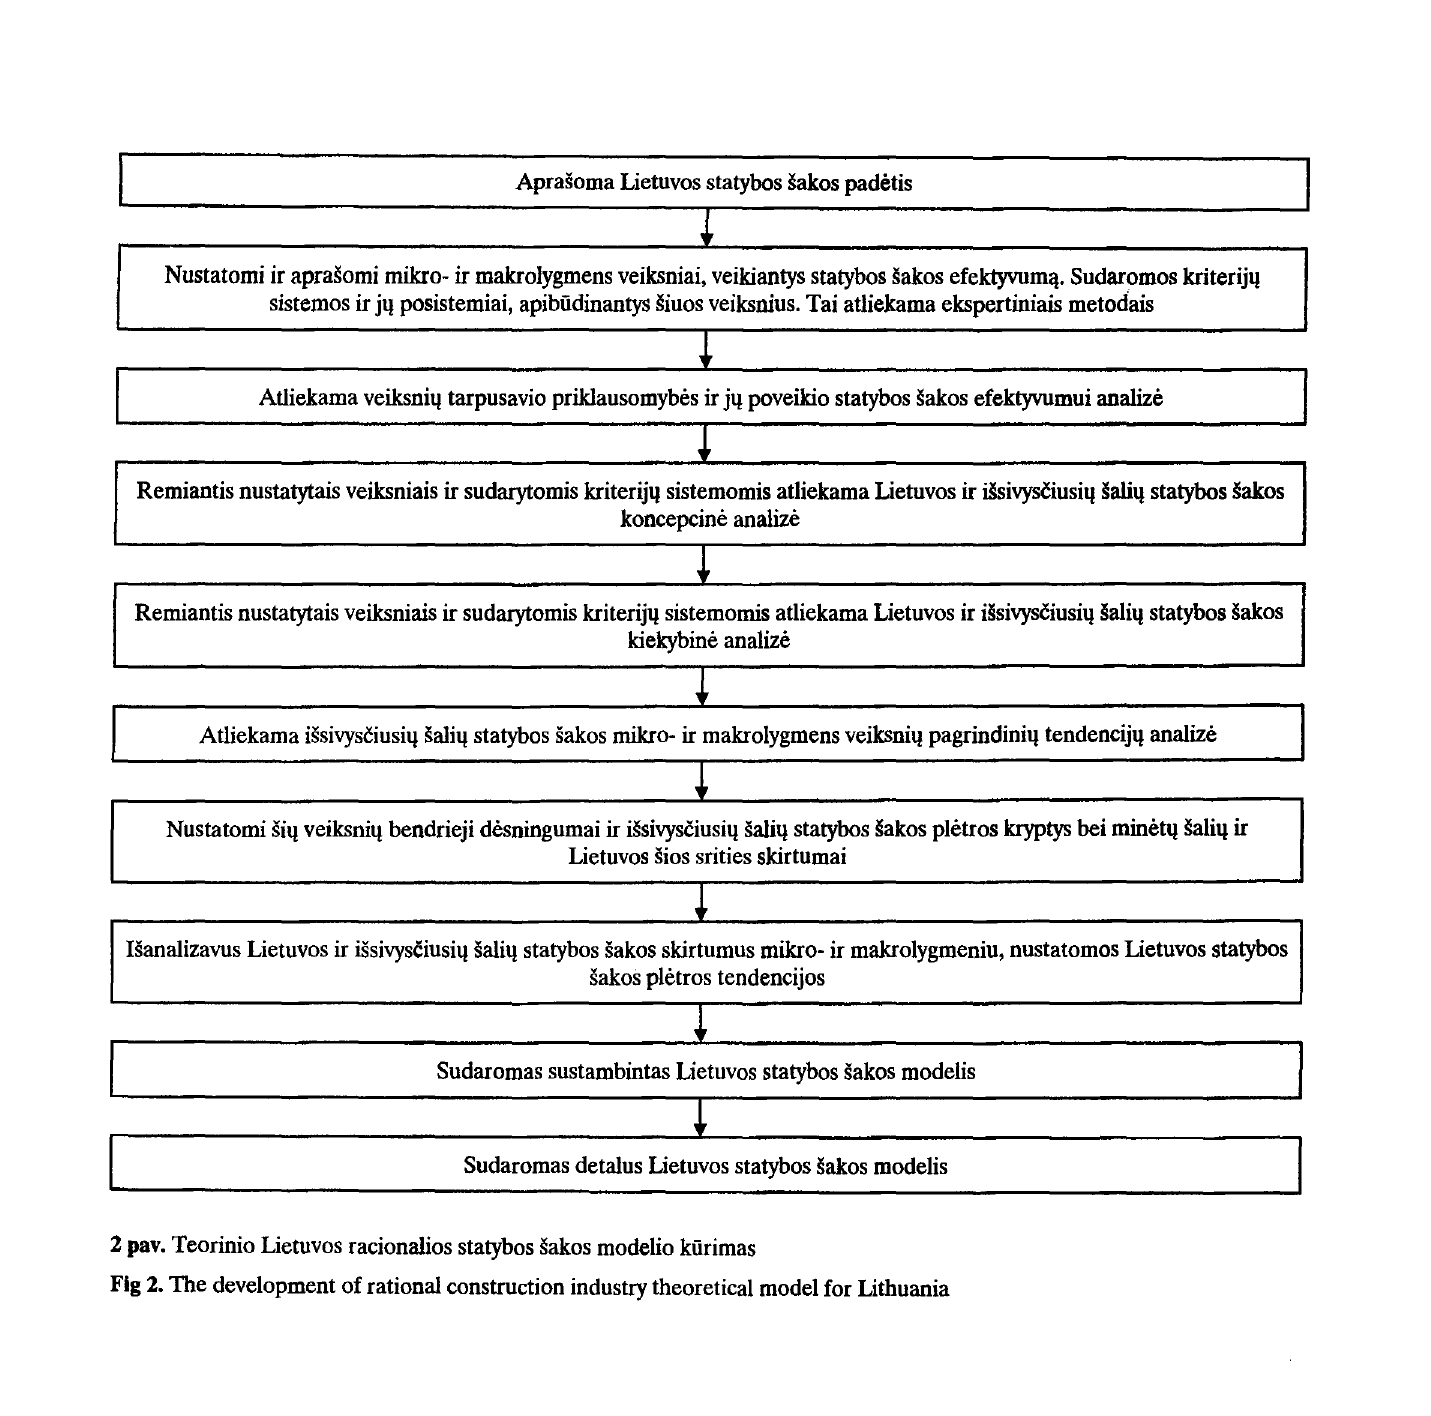
Nagrinejant tik kelias issivysCiusias salis, galima prieiti prie gana subjektyviq isvadq. Taciau nagrine jant daugiau saliq, analizes objektyvumo lygi galima